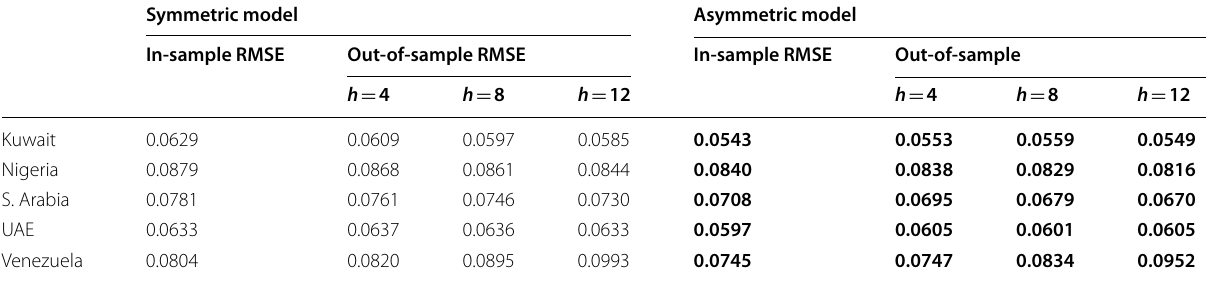
The bolded values are the smaller RMSE values, which give better forecasting accuracy of the predictive